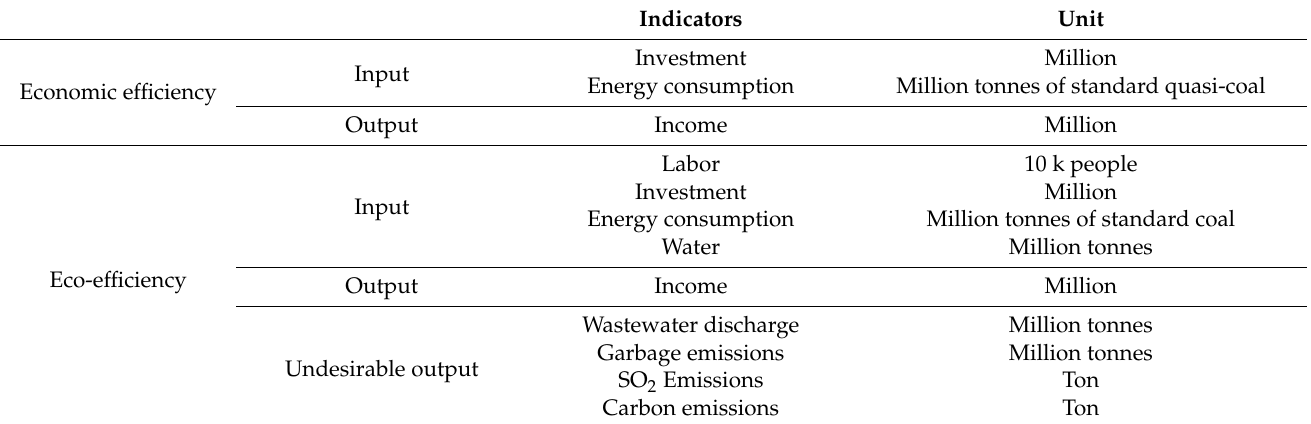
Table 1. Economic efficiency and eco-efficiency input–output indicators for tourist